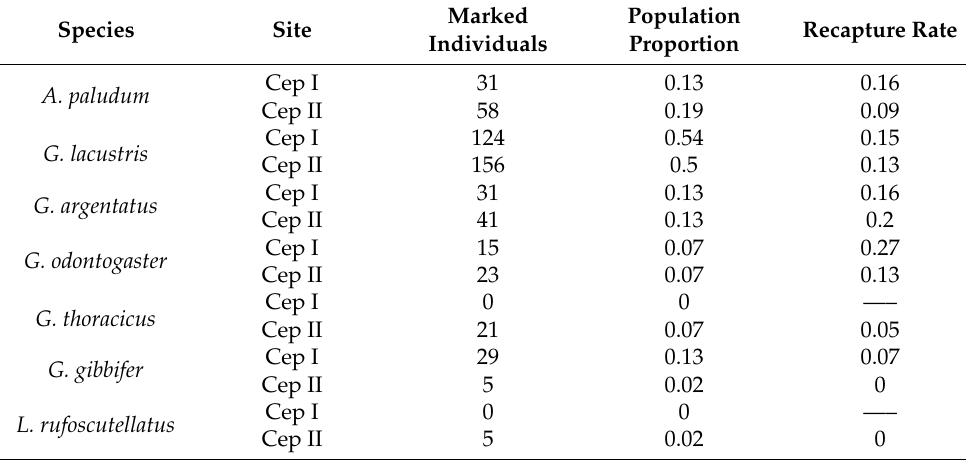
Table 5. Summary of marked individuals and catches at Cep I and Cep II small-pools systems. Data pooled from all